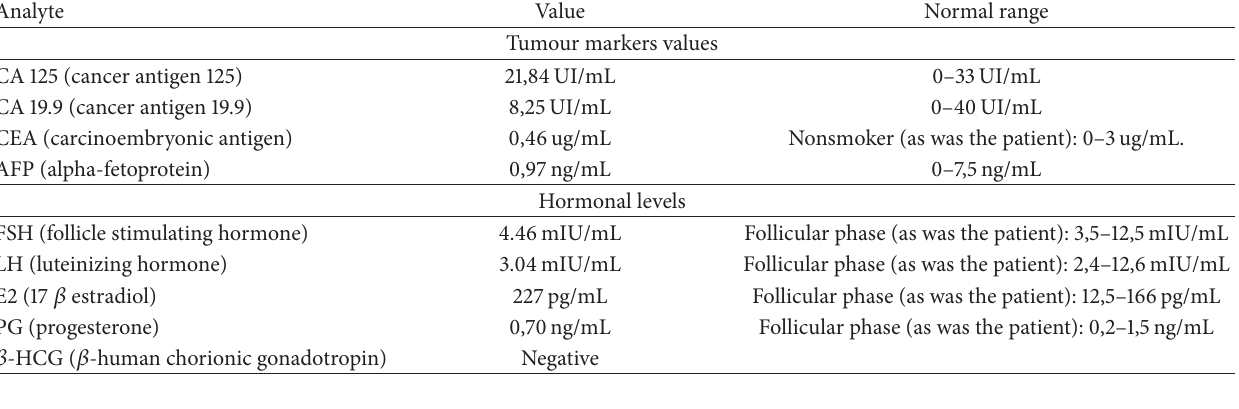
Table 1: Tumour markers and hormonal levels.